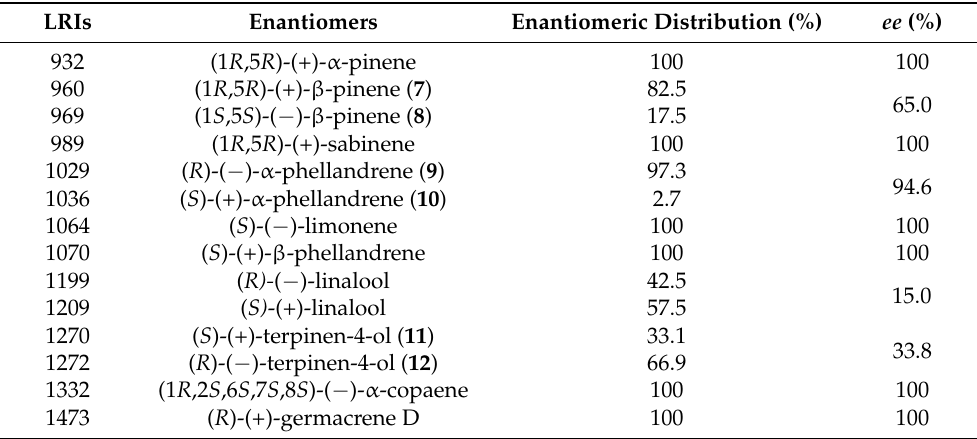
Figure 6. Enantiomeric pairs detected by GC enantioselective analysis: (1 R ,5 R )-(+)- β -pinene ( 7 ), (1 S ,5 S )-(–)- β -pinene ( 8 ), ( R )-( − )- α -phellandrene ( 9 ), ( S )-(+)- α -phellandrene ( 10 ), ( S )-(+)-terpinen-4-ol ( 11 ), and ( R )-( − )-terpinen-4-ol ( 12 ). Table 2. Enantioselective analysis of K. longipetiolata EO on a 2,3-diethyl-6- tert -butyldimethylsilyl- β -cyclodextrin-based GC column.